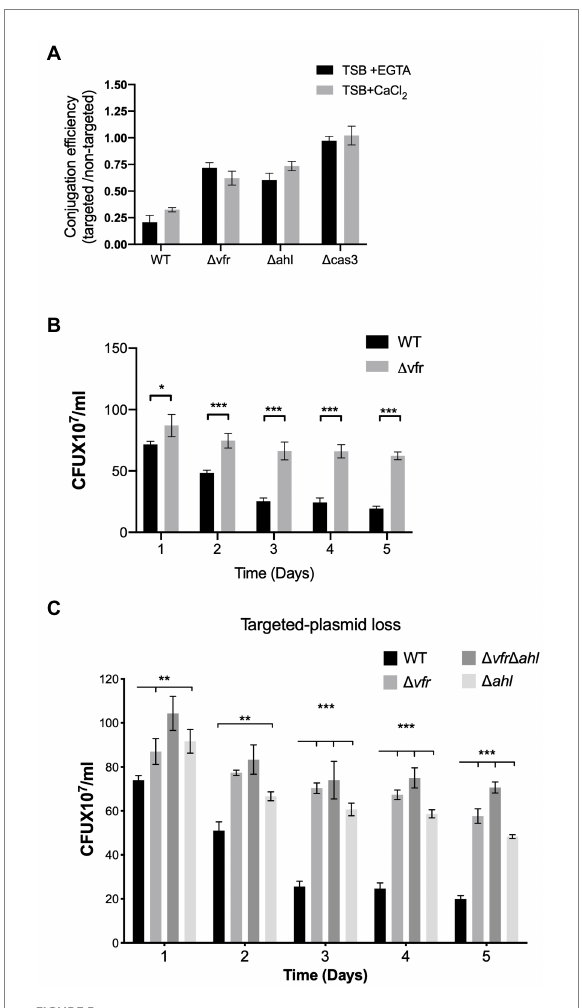
FIGURE 5 Vfr influences Crispr-Cas adaptation and HGT interference. (A) Conjugation efficiency of the WT and Δ vfr , Δ ahl and Δ cas3 strains. The conjugation efficiency is calculated as the ratio of